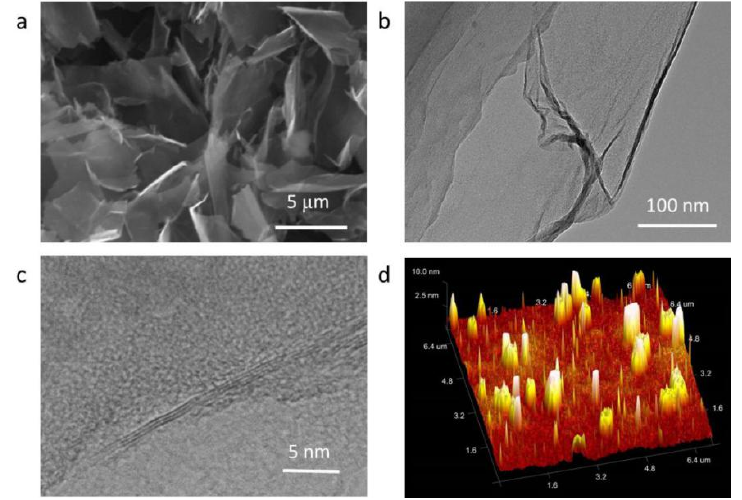
Figure 1. ( a , b ) SEM micrographs of EG, ( c ) XRD patterns of delaminated products of EG in water and SDS solution, ( d ) Raman spectrum of GNPs with inserted spectra of EDG, EG and GNPs.